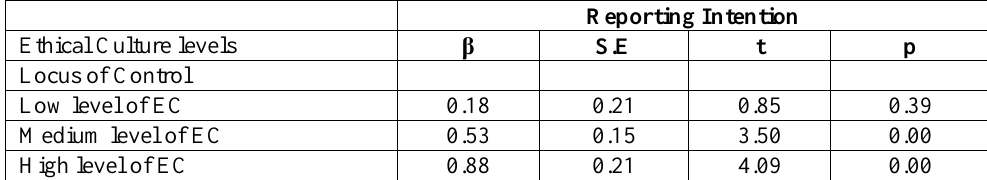
Table 5. The Effect of Locus of Control on Auditor intention for Reporting Misstatements at Low, Medium and High Levels of Ethical Culture (Simple Slopes